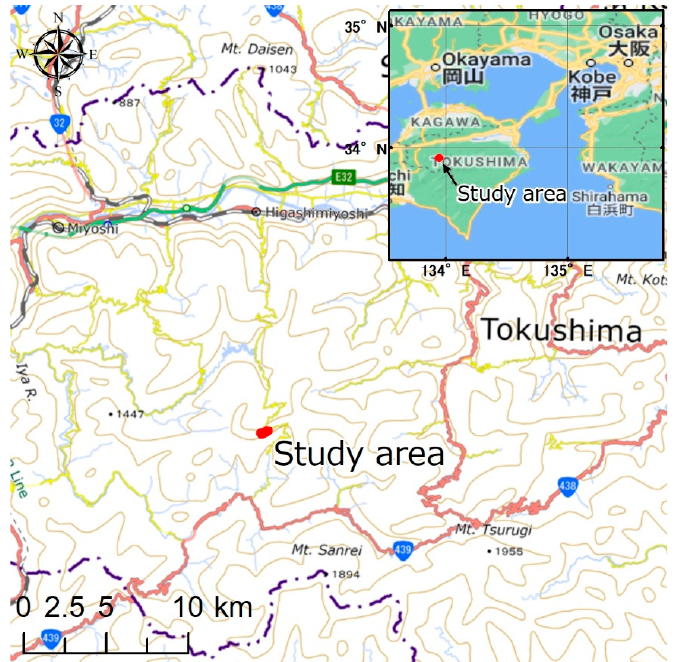
Figure 1. Study site.